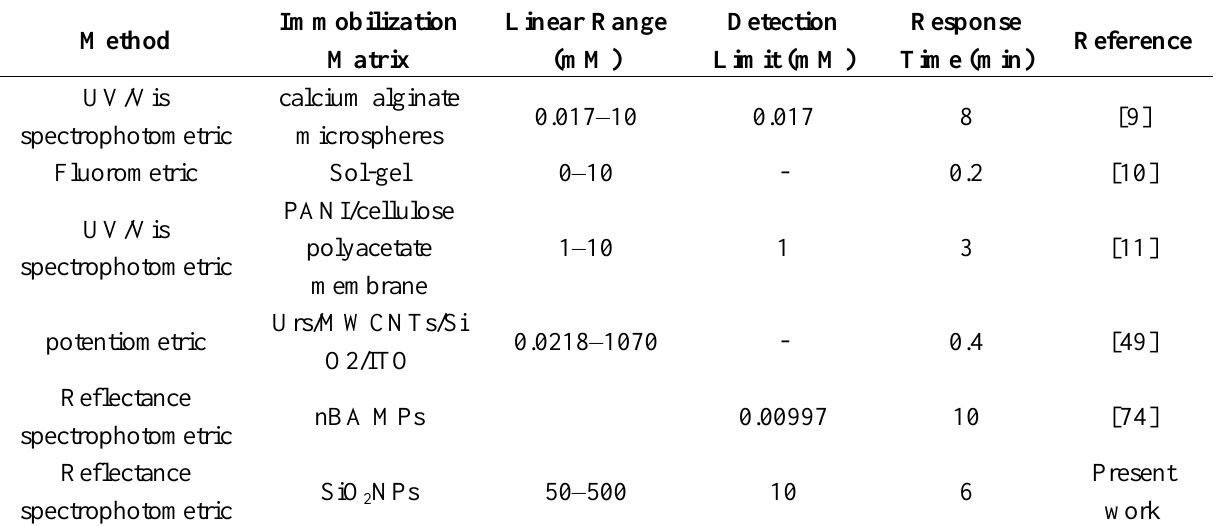
Table 4. Summary of some reported nanoparticles-based optical urea biosensors and the biosensor reported in this